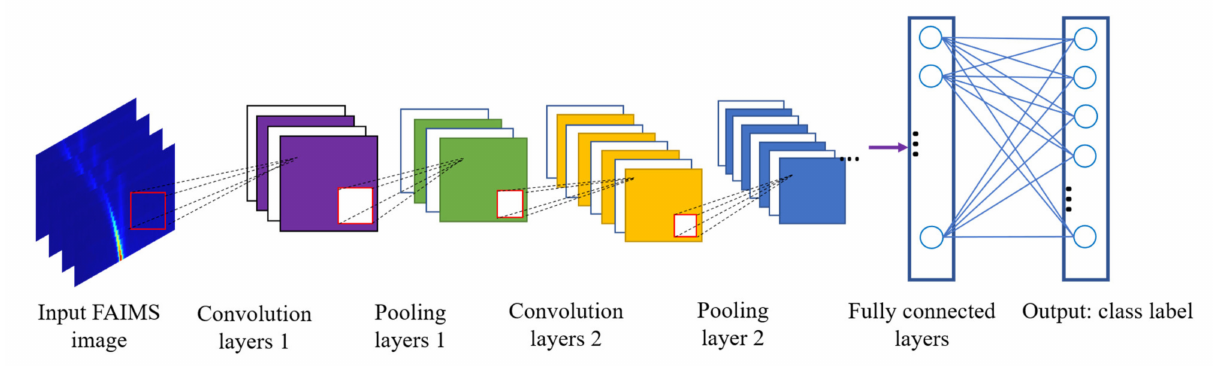
Figure 2. The structure of a typical convolutional neural